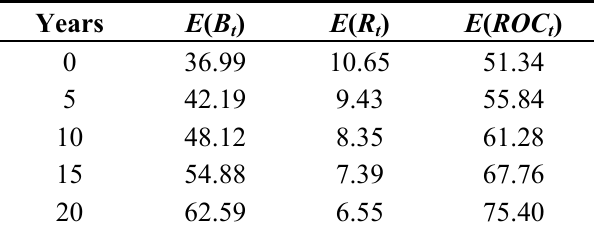
Table 4. Expected ROC price